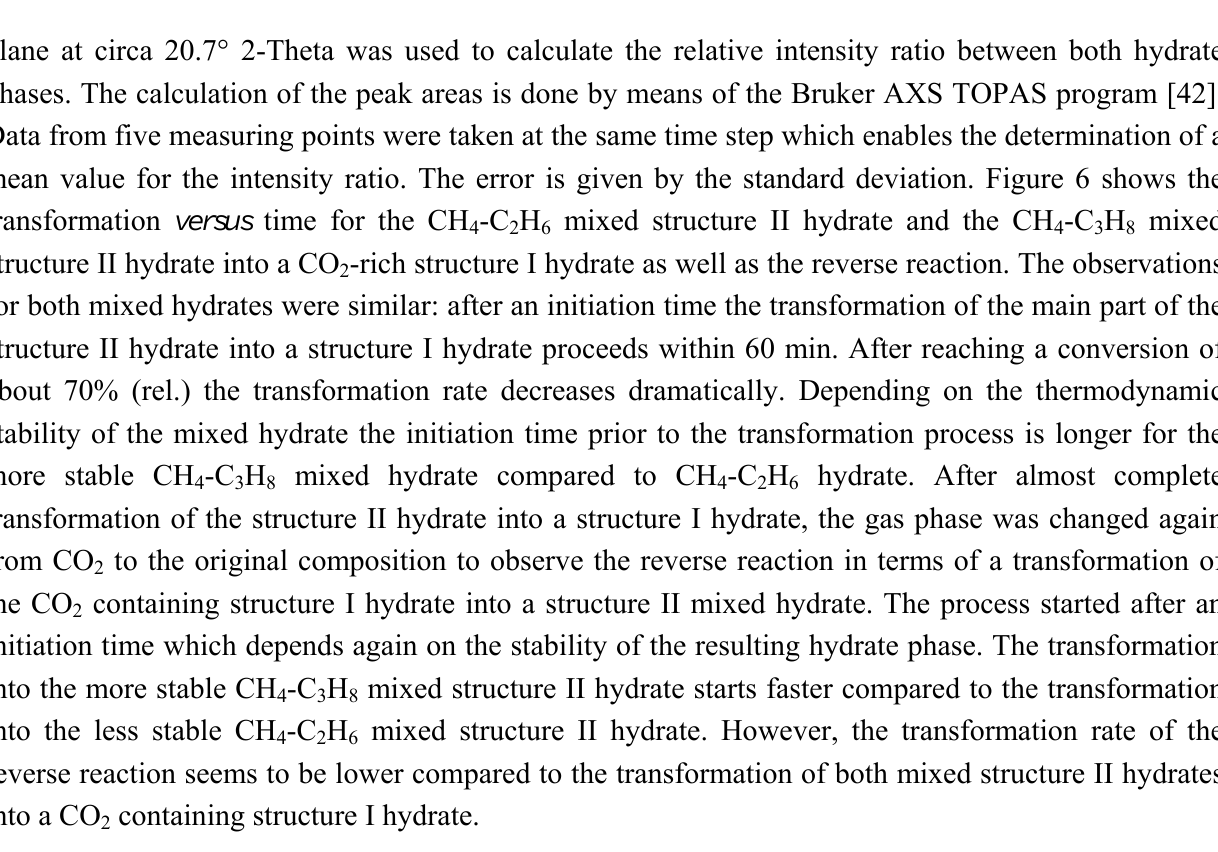
-C H structure II mixed hydrate and CH 4 2 6 -rich structure I hydrate over time as well as the 2